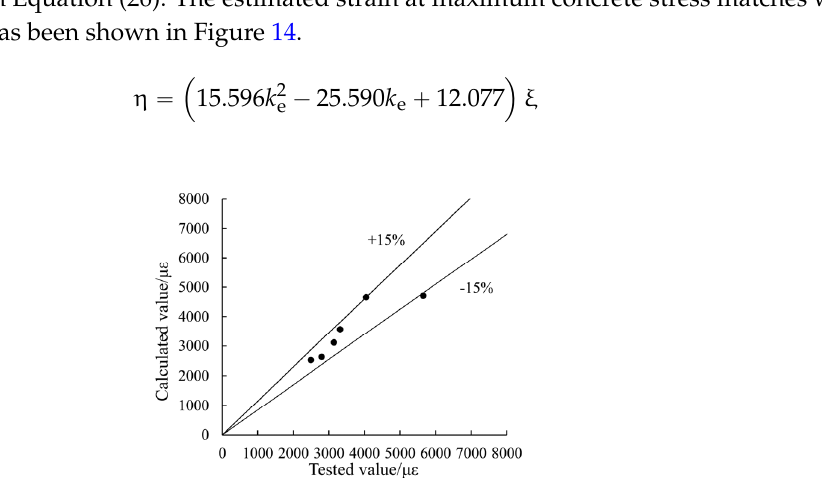
Figure 14. A comparison between the estimated values and the tested values of strain at maximum concrete stress.